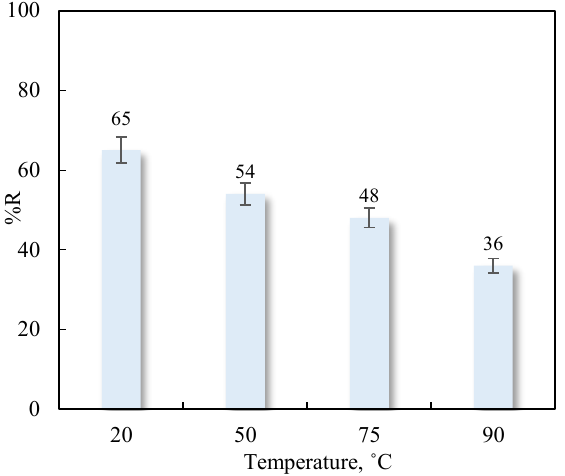
Figure 7. Influence of temperature on Cu (II) adsorption on marble waste sludges (pH = 5; C 0 = 25 mg L −1 , 0.1 g of adsorbent).